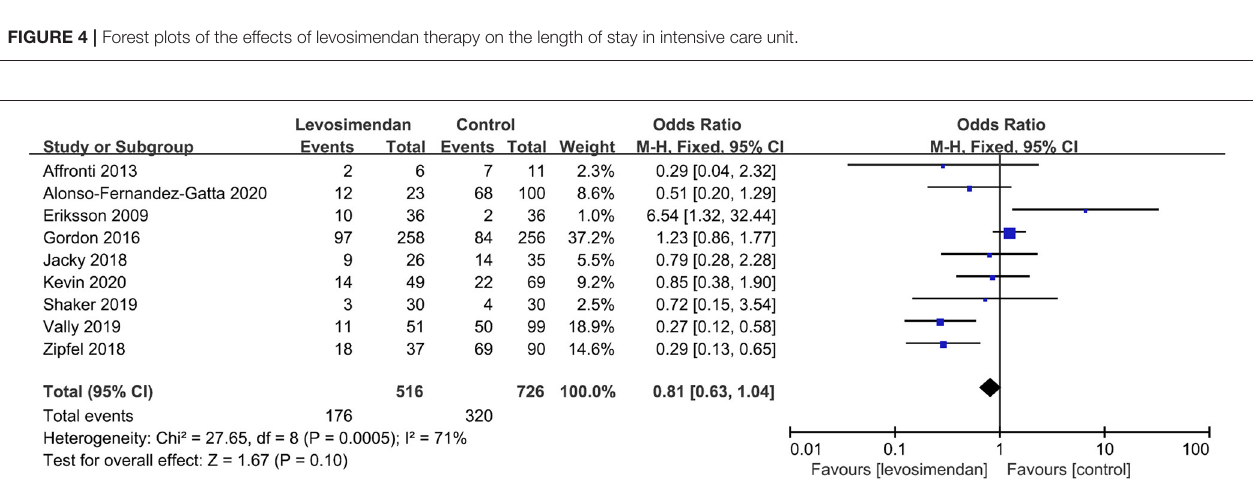
FIGURE 5 | Forest plots of the effects of levosimendan therapy on overall